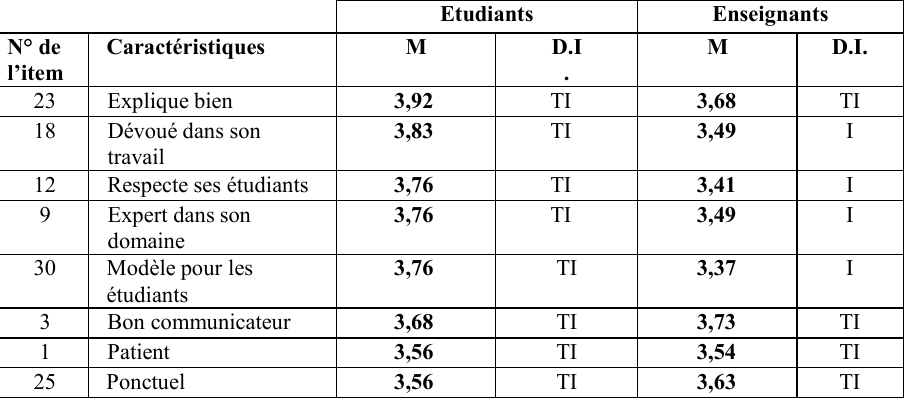
Tableau 1 : Degré d’importance des 30 caractéristiques de l’enseignant efficace selon les points de vue des enseignants et des étudiants (L1). Etudiants